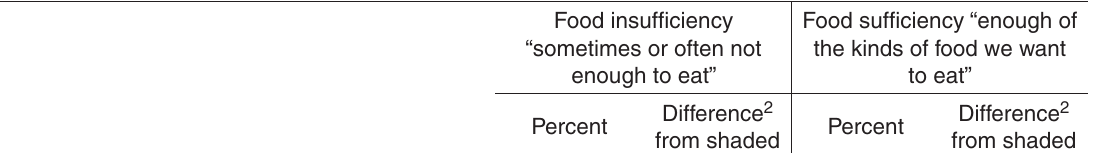
Panel A: household food security status on current and experimental classification methods and raw score Food secure (raw score